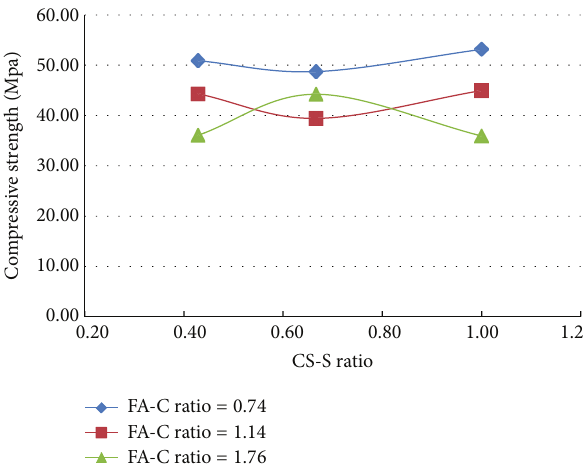
Figure 8: Effect of addition of fibres (CS-S ratio = 0.67).